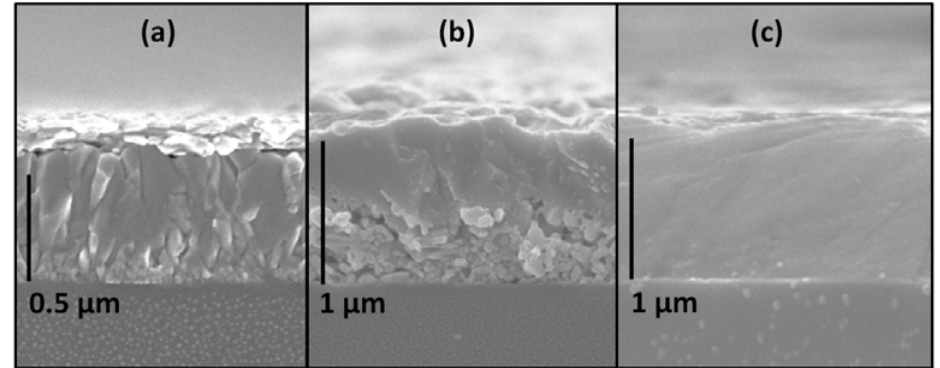
Figure 3. SEM micrographs of the cross-sections of films: ( a ) the precursor film deposited from 0.75 M solution, ( b ) the same precursor film at initial stage of the conversion, and ( c ) the resulting perovskite film after full conversion (20 s) and short annealing (5 min, 100 °C) . Figure 4. SEM micrographs of top surface of films: ( a ) the precursor film and ( b ) its enlarged fragment, and ( c ) the final perovskite film.